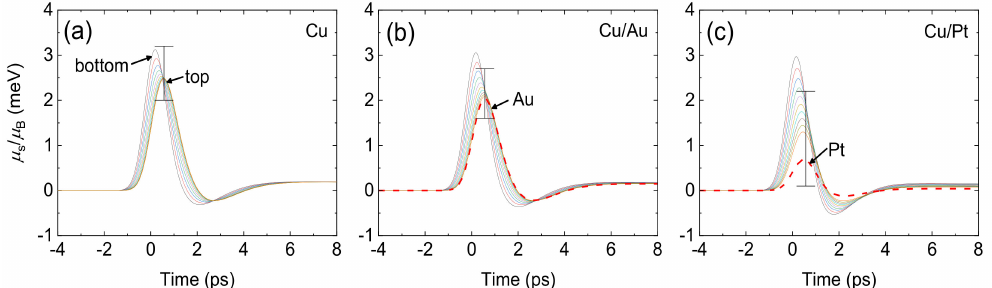
Figure 4. Calculation of the spin accumulation on NM. Spin chemical potentials along the thickness of NM of the Pt(10)/FM(3.8)/NM structure, where NM is ( a ) Cu(100)/MgO(3), ( b ) Cu(100)/Au(10), or ( c ) Cu(100)/Pt(2). Solid lines represent the spin chemical potentials of Cu, and every line is an average of 10 nm thickness starting from the bottom (the FM/Cu interface) to the top surface. Red dashed lines represent the spin chemical potentials of Au (average of 10 nm thickness) in ( b ) and of Pt (average of 2 nm thickness) in ( c ).